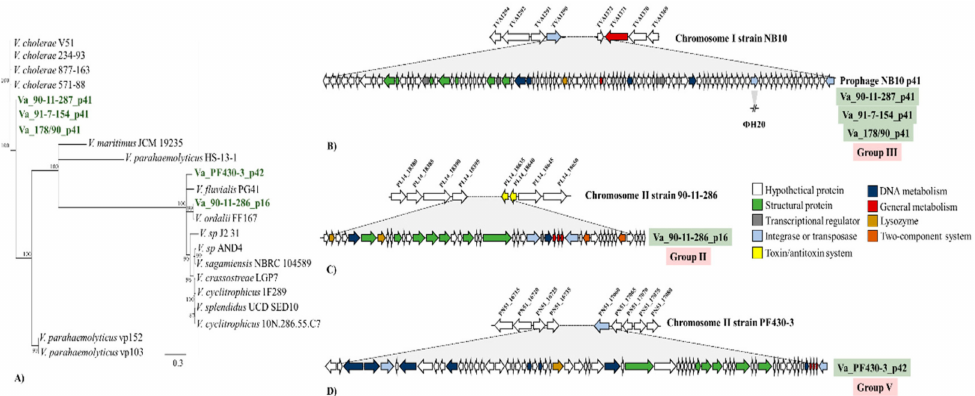
Figure 3. Genetic relationship and schematic representation of V. anguillarum temperate phages. ( A ) Phylogenetic relationship of temperate phages based on terminase large subunit protein sequence.